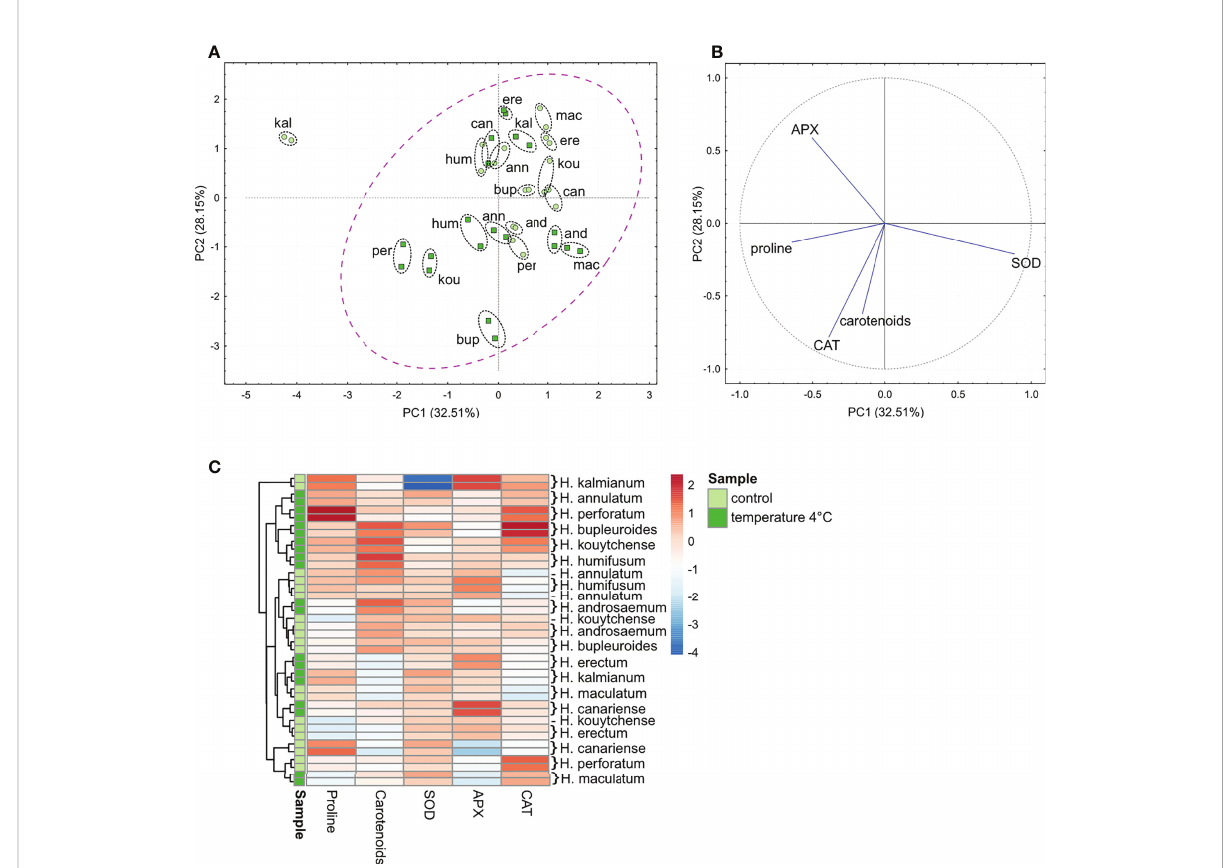
FIGURE 3 The PCA (A, B) and HCA (C) analyses of non-enzymatic (proline, carotenoids) and enzymatic (SOD, CAT, APX) antioxidant systems assessed in the extracts of shoots of in vitro- grown H.ypericum spp. A magenta-colored ellipse is drawn around the cluster of most of the species (cases) (A) in relation to content of non-enzymatic antioxidants, and activity of antioxidant enzymes (variables) (B) . Each species is represented by two biological replicates (highlighted with a black ellipse drawn around each pair of points per species). The HCA dendrogram (C) shows clustering of the species according to the branches. Each square in the heatmap dendrogram (C) represents relative content of a non-enzymatic antioxidants, or activity of antioxidant enzymes; an increase and a decrease is represented by the red and blue color. Light green and dark green color of the samples indicate the variables in control plants and plants exposed to temperature of 4°C. (For interpretation of the references to color in this fi gure legend, the reader is referred to the Web version of this article.) kou, H. kouytchense ; and, H. androsaemum ; bup, H. bupleuroides ; per, H. perforatum ; mac, H. maculatum ; ere, H. erectum ; hum, H. humifusum ; kal, H. kalmianum ; can, H. canariense ; ann, H. annulatum